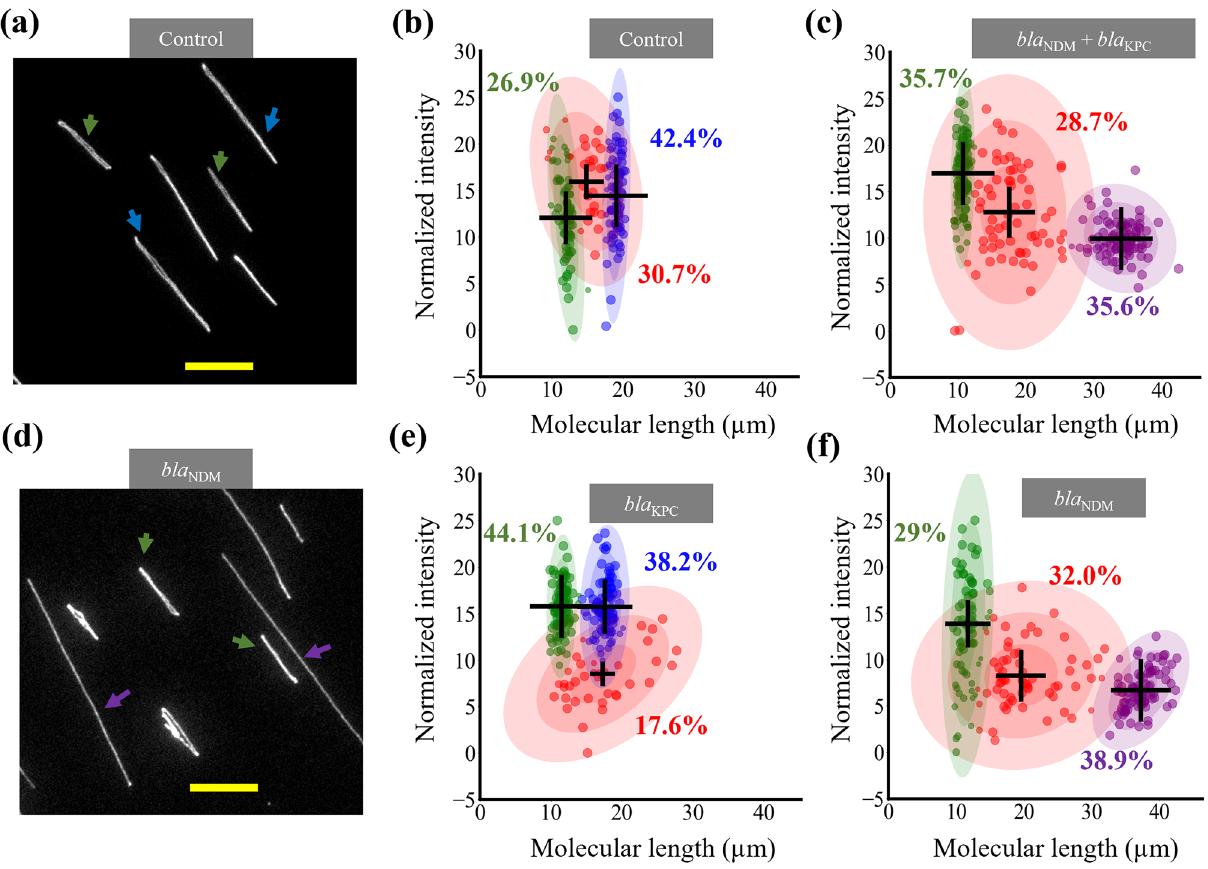
Figure 3. Carbapenemase gene detection in a sample with two plasmids. ( a ) Image of plasmid sample after the control reaction. The two plasmids observed are marked with green and blue arrows, respectively. ( b , c ) Length and intensity per pixel after the control reaction ( b ) and the carbapenemase gRNA cocktail reaction ( c ) clustered using GMM. ( d ) Image of plasmid sample after the bla NDM reaction. The larger plasmid in ( a ) was not observed. The smaller plasmid is marked with green arrows and the linearized larger plasmid is marked with purple arrows. ( e , f ) Data clustered after separate bla KPC ( e ) and bla NDM ( f ) reactions. The population clusters identified by the algorithm are presented in different colors. The mean values are marked with ‘ + ’ signs (scaled to the weights of the clusters). The percentage values represent the percentage of the population in that cluster. The colored ellipses represent the standard deviations of the mean. Scale bars 10